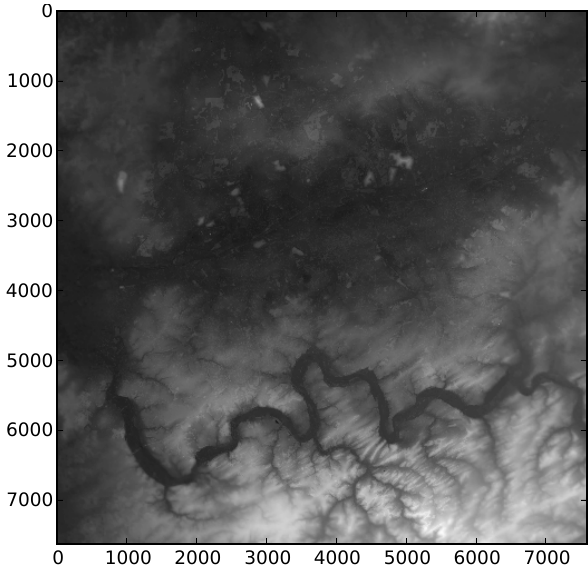
Figure 1: Digital Elevation Model